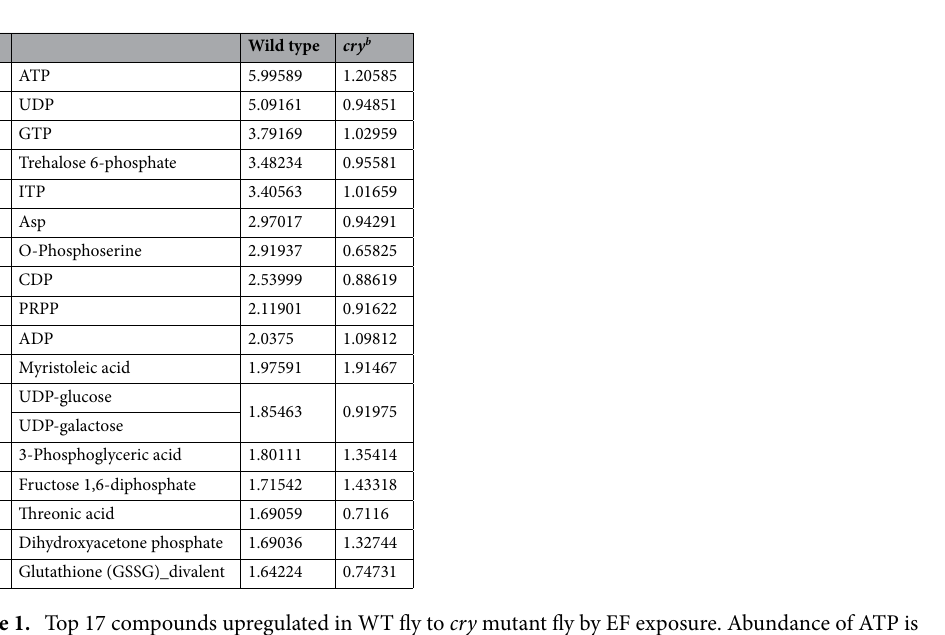
Figure 4. Metabolome analysis after EF exposure. ( a ) Hierarchical cluster analysis of metabolome separation. Heat maps show differences in metabolites between control (Ctrl) and EF exposure. Red and green, high and low expression, respectively. Columns represent different conditions (Ctrl and EF, constant darkness without and with electric field). ( b ) Comparison of upregulated compounds in WT and cry mutant flies. Expression of compounds in WT and cry mutant is arranged in descending order. ATP is most upregulated by EF. ATP, adenosine triphosphate; EF electric field, WT wild type.